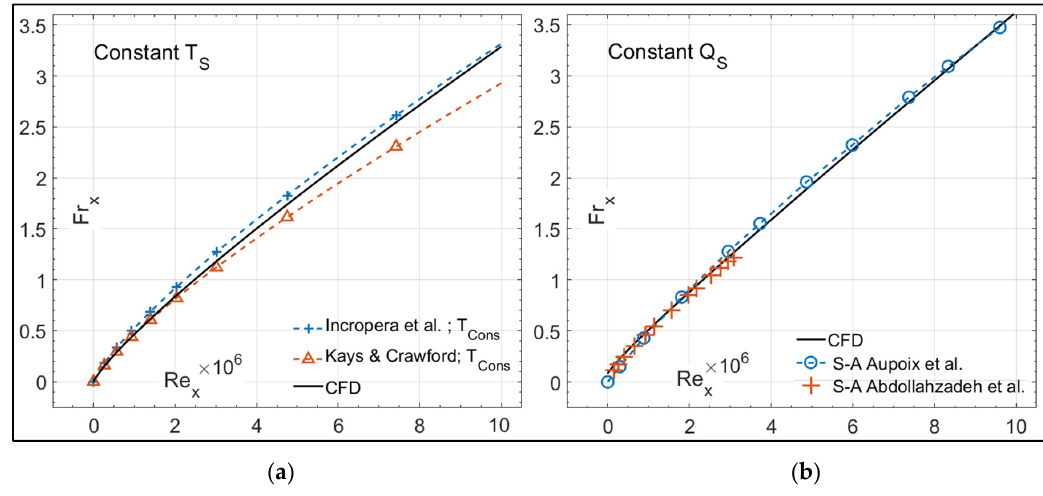
Figure 5. Comparison of Fr obtained by CFD versus correlations for constant: ( a ) Q ; ( b ) T S.